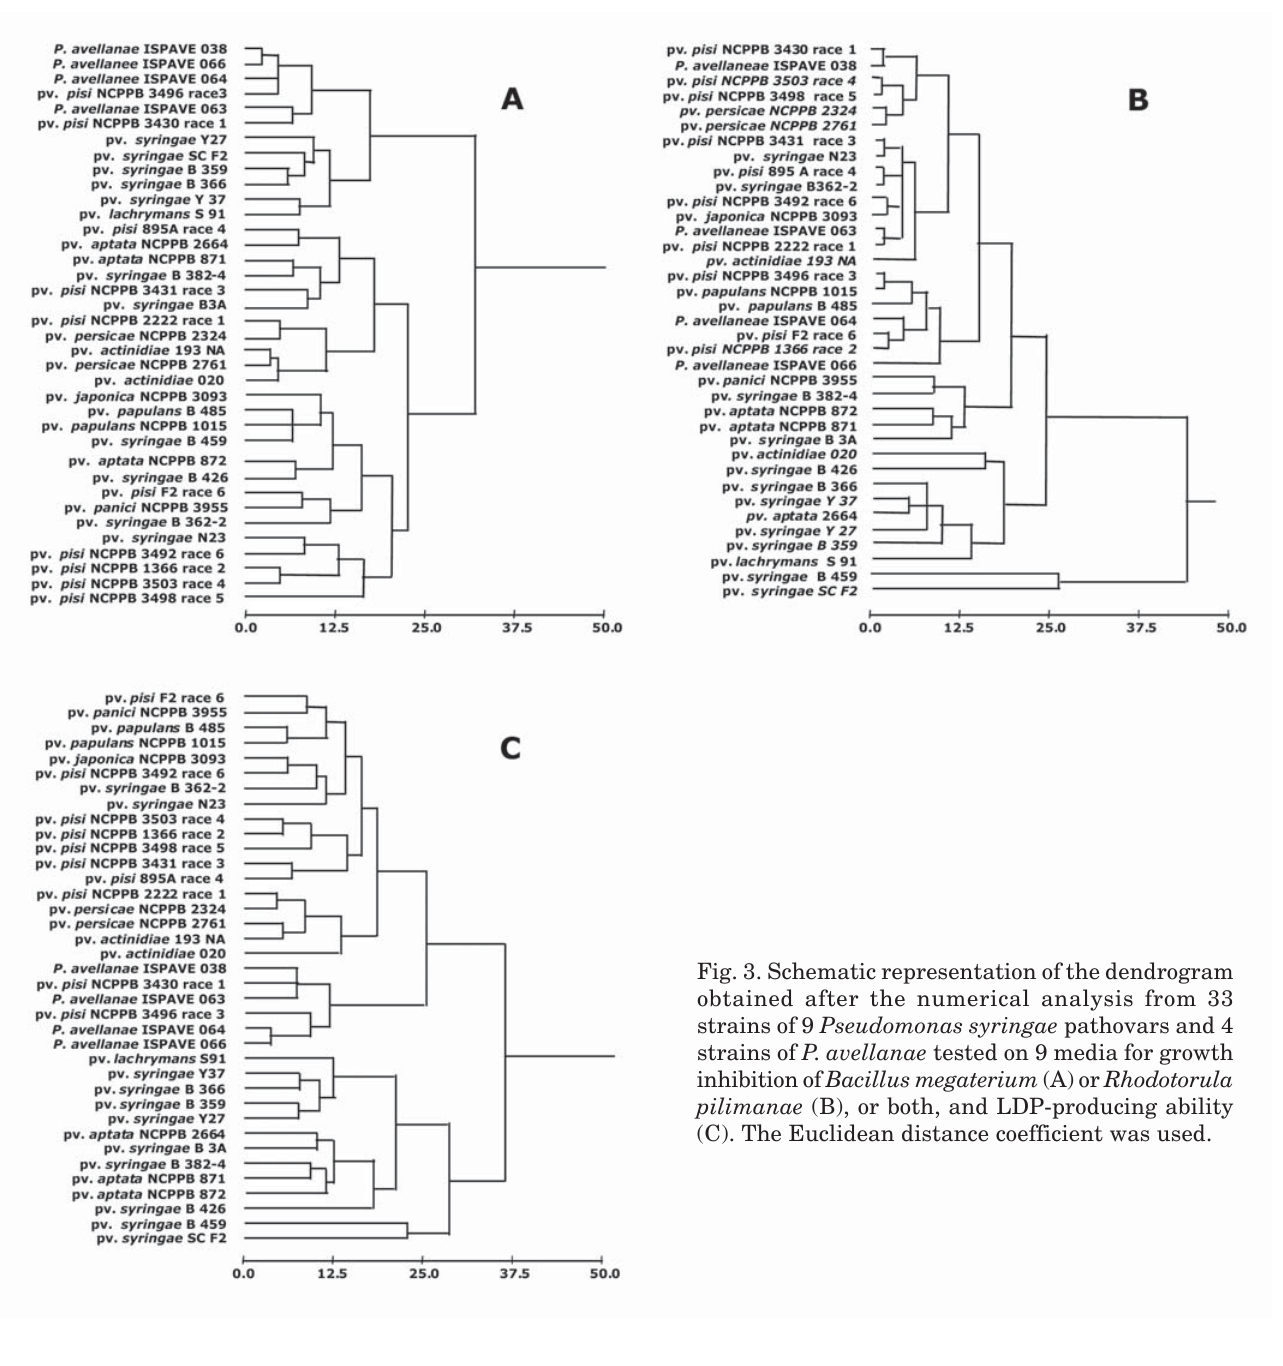
Fig. 3. Schematic representation of the dendrogram obtained after the numerical analysis from 33 strains of 9 Pseudomonas syringae pathovars and 4 strains of P. avellanae tested on 9 media for growth inhibition of Bacillus megaterium (A) or Rhodotorula pilimanae (B), or both, and LDP-producing ability (C). The Euclidean distance coefficient was